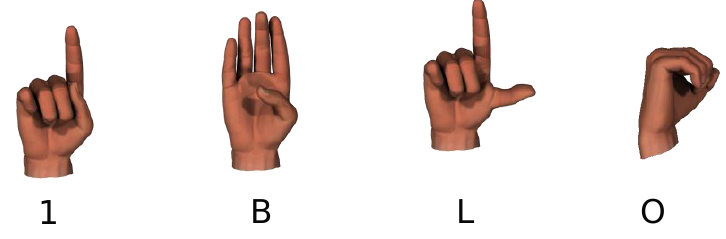
Figure 4. Examples hand shape used for training the BoostMap